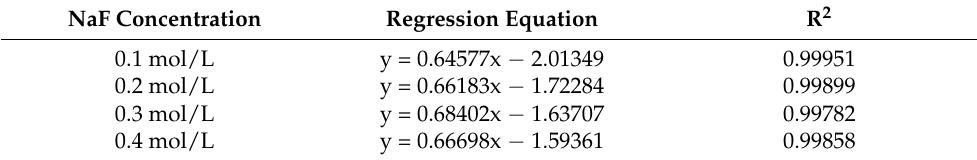
Table 5. Fitting results between ln[ − ln(1 − η )] and lnt under different NaF additions. NaF Concentration Regression Equation NaF Concentration